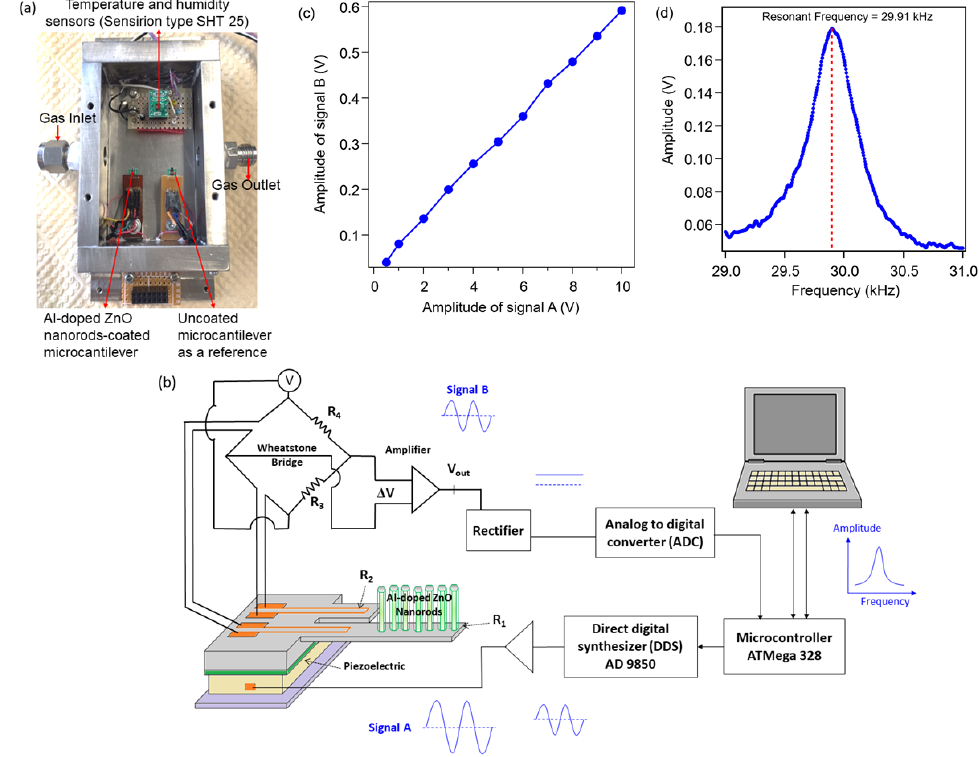
Figure 2. ( a ) View of the inside chamber box made of stainless-steel with a size of 8 cm × 5 cm × 2 cm; ( b ) resonant frequency measurement system based on a microcontroller-controlled direct digital synthesizer (DDS); ( c ) amplitude of signal B as a function of signal A, which vibrates the microcantilever with a resonant frequency of 36.2 kHz; ( d ) profile of the vibration amplitude vs frequency for Al-doped ZnO nanorod-coated